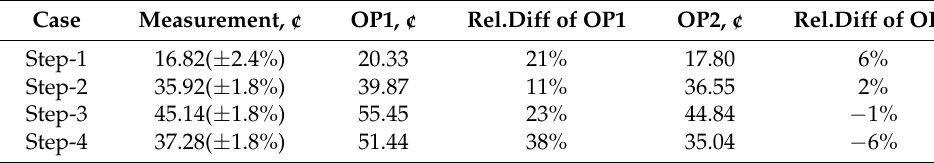
Table 7. Results and comparison of SVR value of